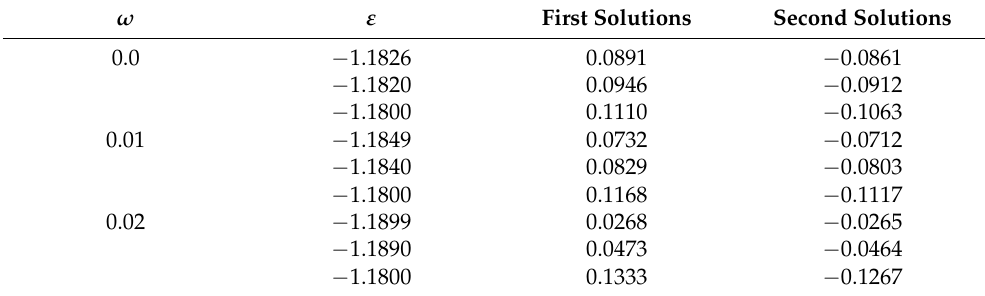
Table 6. Minimum eigenvalues γ for multiple values of ω and ε when ϕ = 0.02, S = 2.2, and Pr = 6.2 (water) for SWCNT. ω ε First Solutions Second